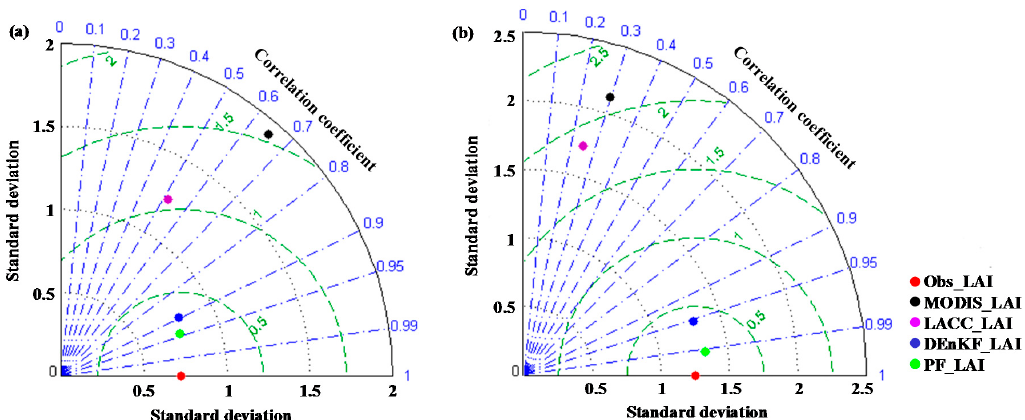
Figure 7. Time series of Obs_LAI, MODIS_LAI and LACC_LAI, DEnKF_LAI and PF_LAI of MBF in 2014 ( a ) and 2015 ( c ), and those of LBF in 2014 ( b ) and 2015 ( d ).